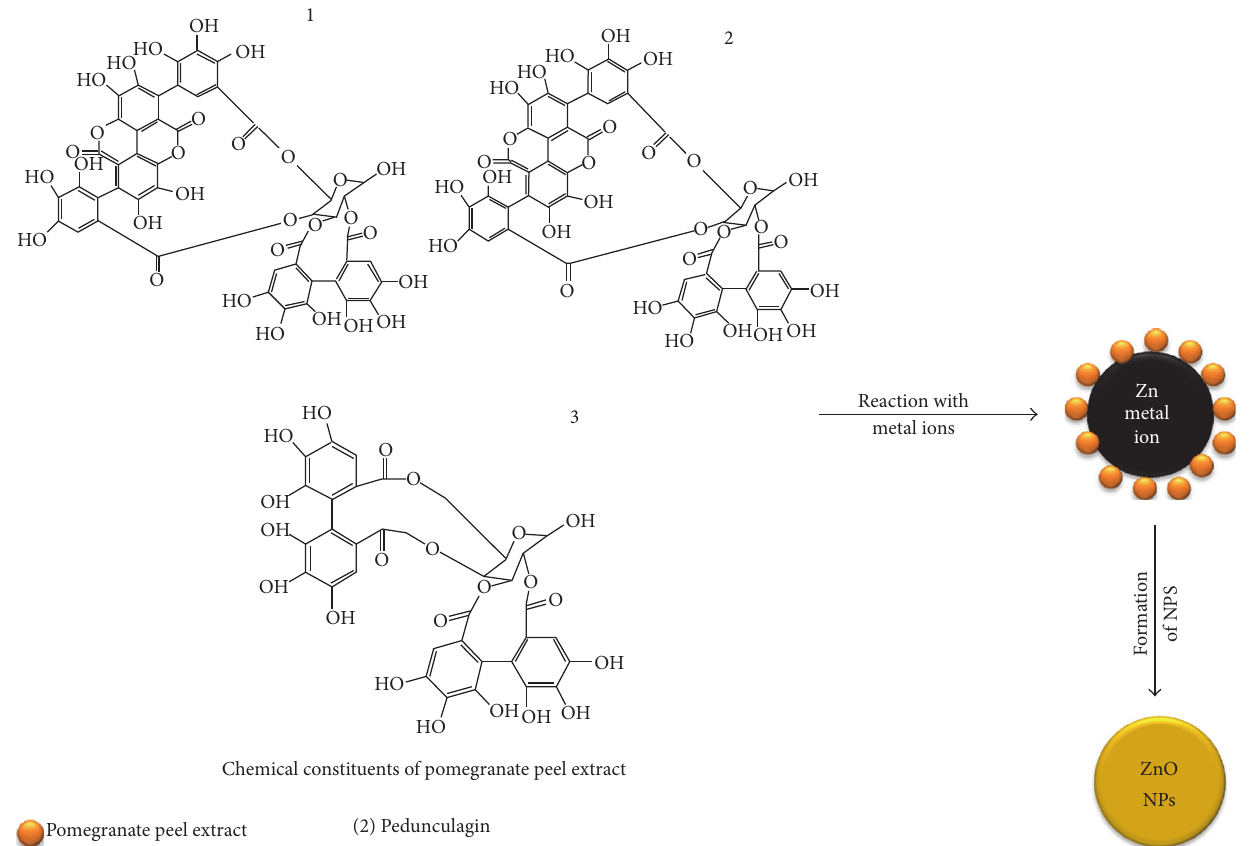
Scheme 1: Schematic representation of ZnO nanoparticle